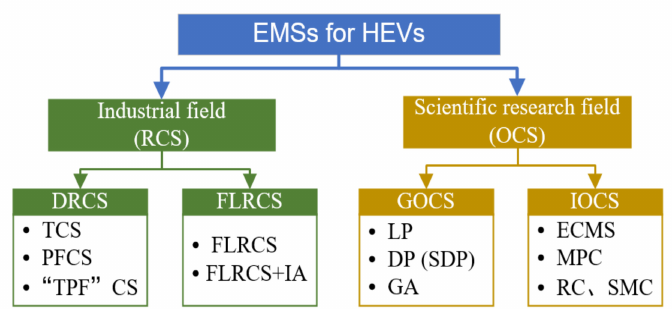
Figure 20. Classification based on practicability.